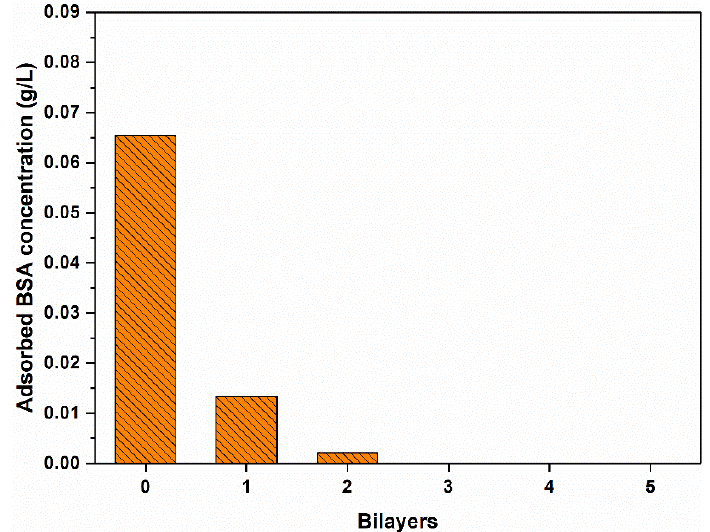
Figure 9. Adsorbed BSA concentration of the PSf membranes with different bilayer numbers under neutral pH.